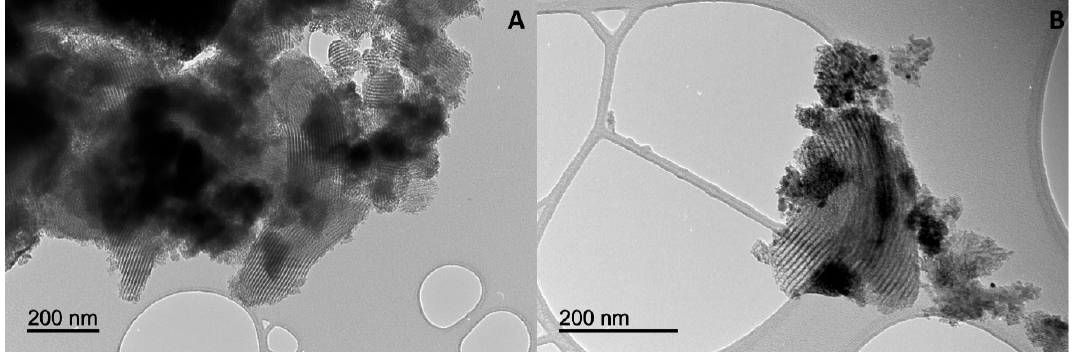
Figure 3. TEM images of ( A ) 40% FeMagC at 400 ◦ C, and ( B ) 40% FeMagN at 400 ◦